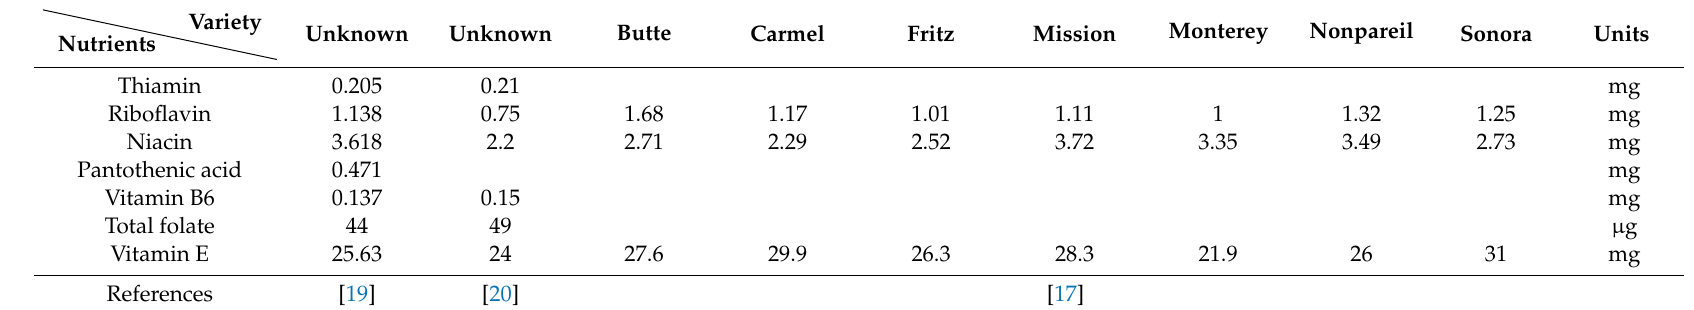
Table 3. Vitamin content (per 100 g) of di ff erent varieties of almonds ( Prunus dulcis Mill. D. A. Webb).